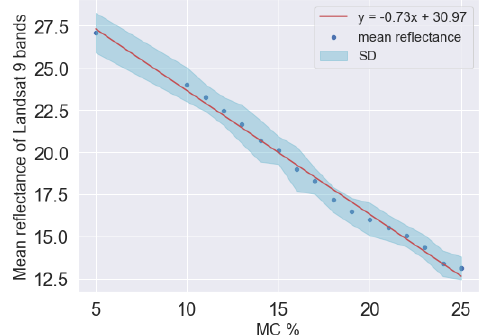
Figure 4(a & b). A linear regression model fitted to reflectance data averaged across the Landsat 9 wavelengths, returns an excellent fit in the domain of 5–25% MC.